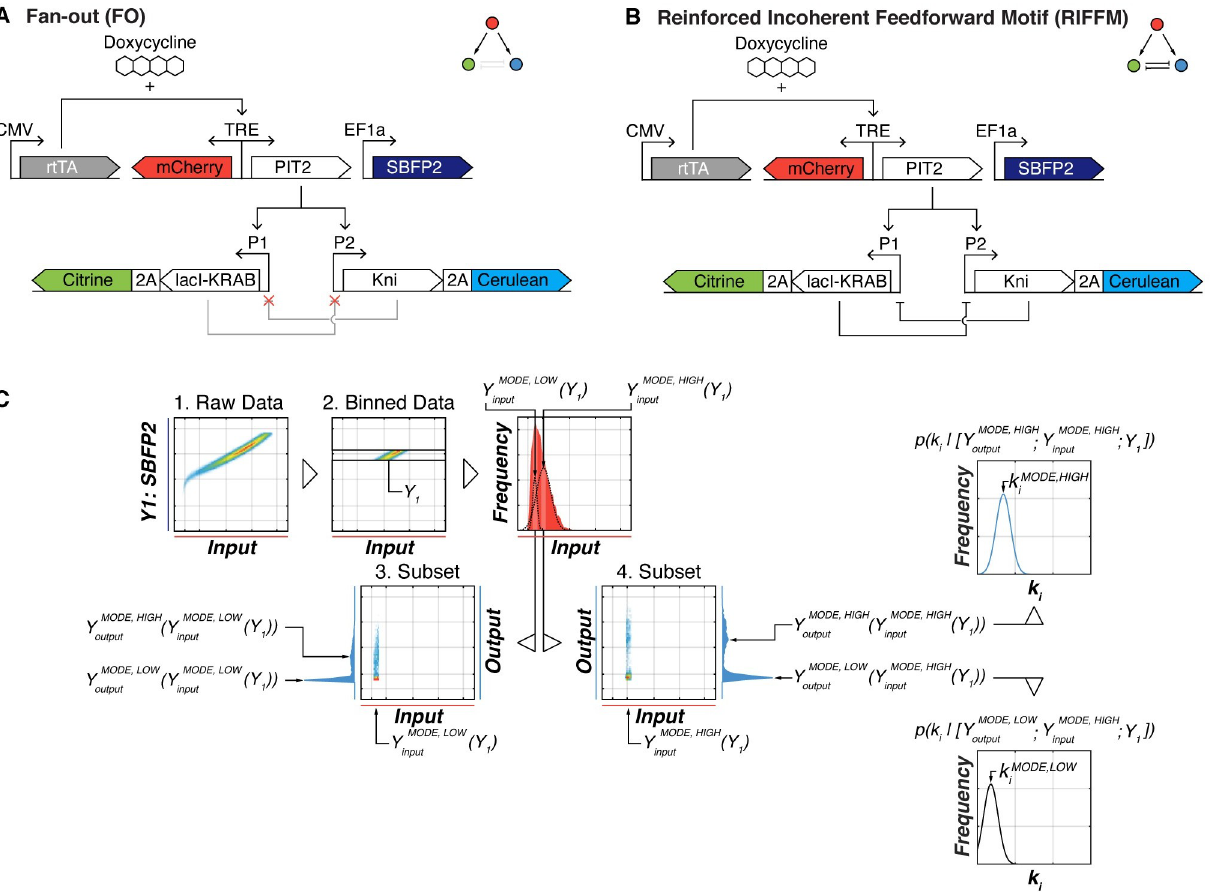
Fig 2. Schematics of gene circuits FO and RIFFM and analysis outline. ( A )| Monomodal/fan-out (FO) and ( B ) bi-modal (RIFFM) gene circuit. The circuits are composed of five independent genes. Constitutively-expressed transcription factor rtTA co-induces PIT2 and the fluorescent protein mCherry in a Doxycycline-dependent fashion. PIT2 in turn activates two promoters P1 and P2, which express a transcriptional repressor lacI-KRAB and Kni, respectively, co-expressed via P2A linkers with Citrine and Cerulean fluorescent reporters. In the FO circuit the repressors do not interact due to mutated promoter binding sites, while in the RIFFM circuit they repress each other, establishing a mutual inhibition. ( C ) Graphical illustration of all steps to find the modes within our simulated data sets. The raw flow cytometry like data ( 1 ) is binned by the transfection marker (i.e. Y 1 : SBFP2). The binned data is isolated and subsequent analysis is done only on this subset ( 2 ). Afterwards the distribution of the log-transformed input signal (mCherry) within the binned subset is determined and at least one Gaussian is fitted to the distribution. A narrow bin(s) around the mode(s) (black arrows) of the fitted distribution(s) is determined (pink bars), thus obtaining a subset of the originally-binned dataset. The subset around the peaks ( Y MODE ; LOW